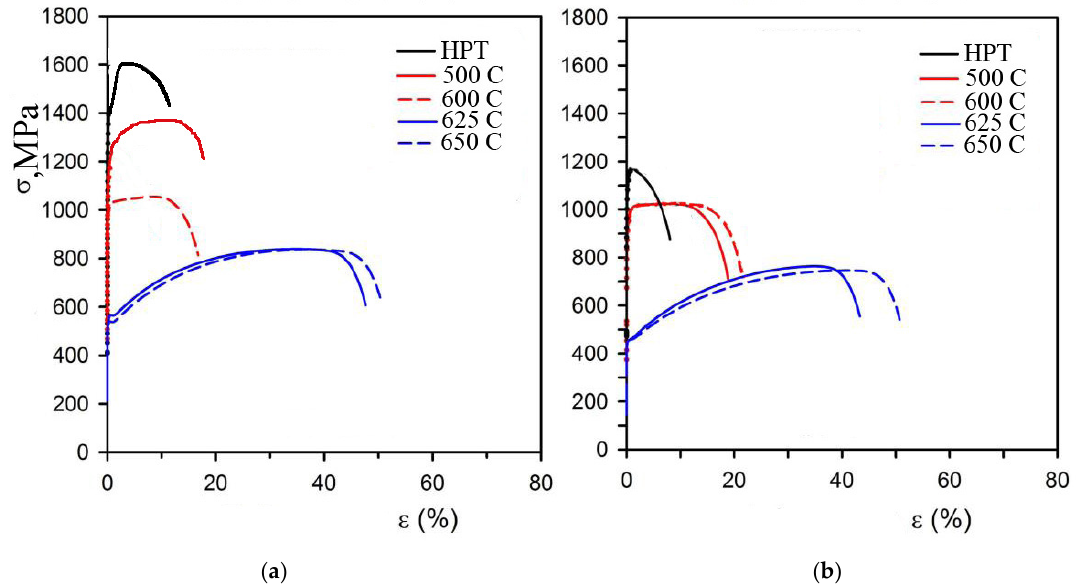
Figure 9. Tensile diagrams of samples obtained after HPT and heating during deformation: ( a ) at cryogenic temperature; ( b ) at room temperature.